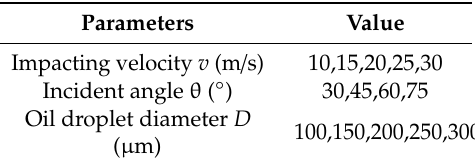
Table 1. Operating